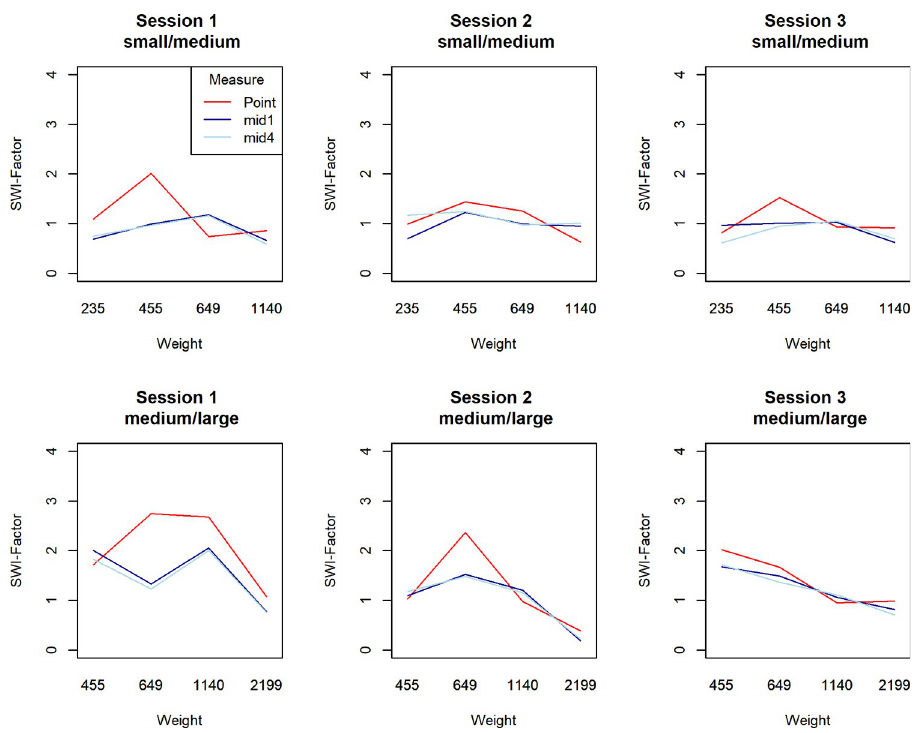
Fig 5. Average SWI-factor depending on weight and judgment method for each judgment session. Separate lines for SWI-factor for small/medium (solid) and medium/large (dotted) comparisons.